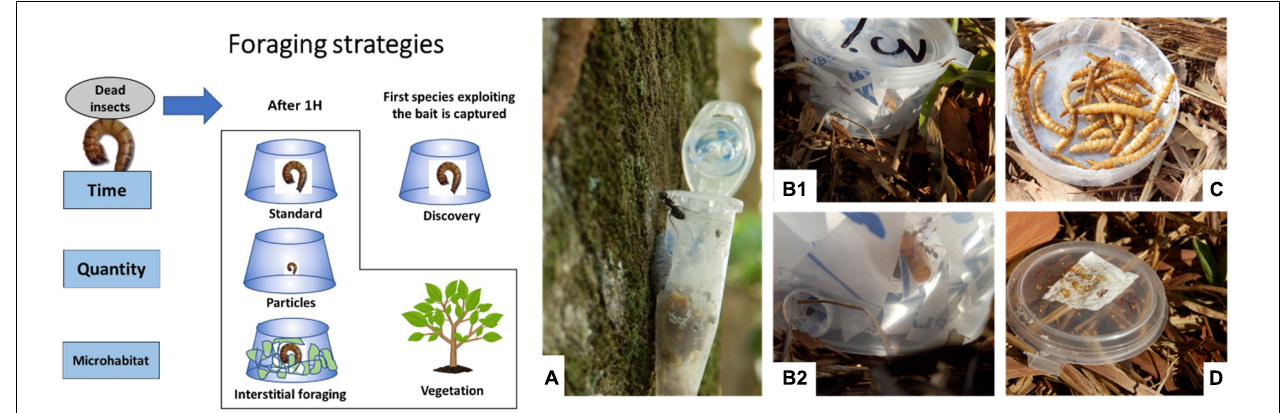
FIGURE 2 | Foraging strategies sampling protocol. The left side of the figure illustrates which environmental factors and niche partitioning dimensions were aimed. At the right, the sampling devices used to emulate different resource acquisition strategies. (A) Vegetation foraging. (B1,B2) Interstitial foraging. (C) The standard bait display also used for the trophic experiment, and applied for both discovery and dominance, and (D) the small particles.